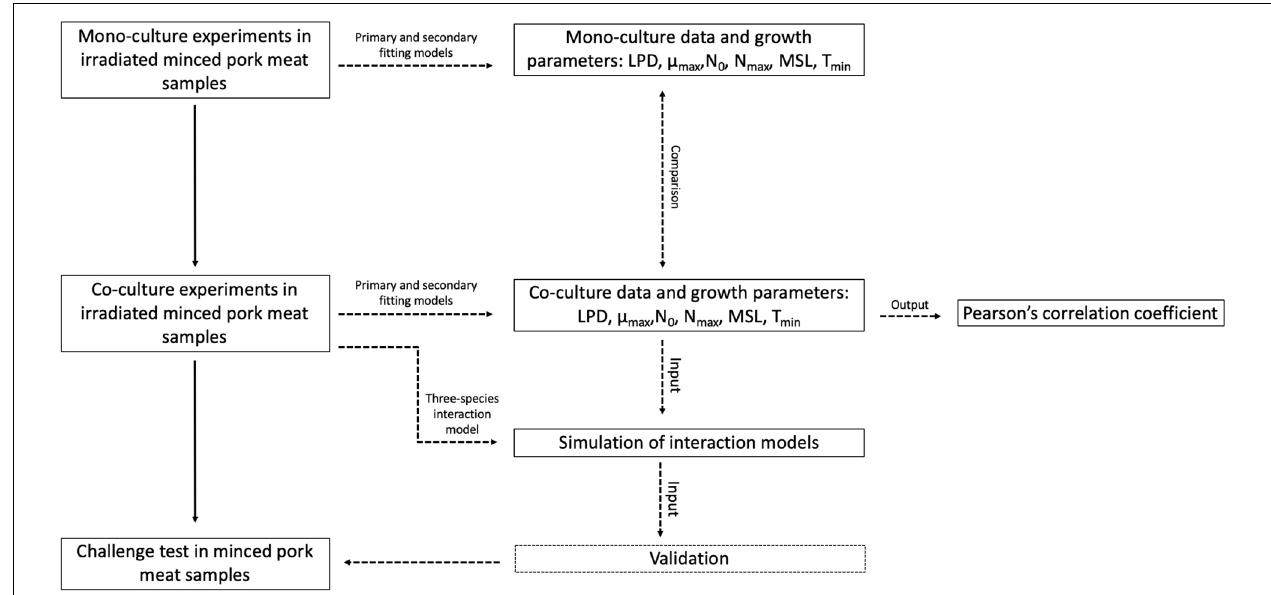
FIGURE 1 | Schematic overview of the step-wise method used for the development of a three-spoilage species interaction model.